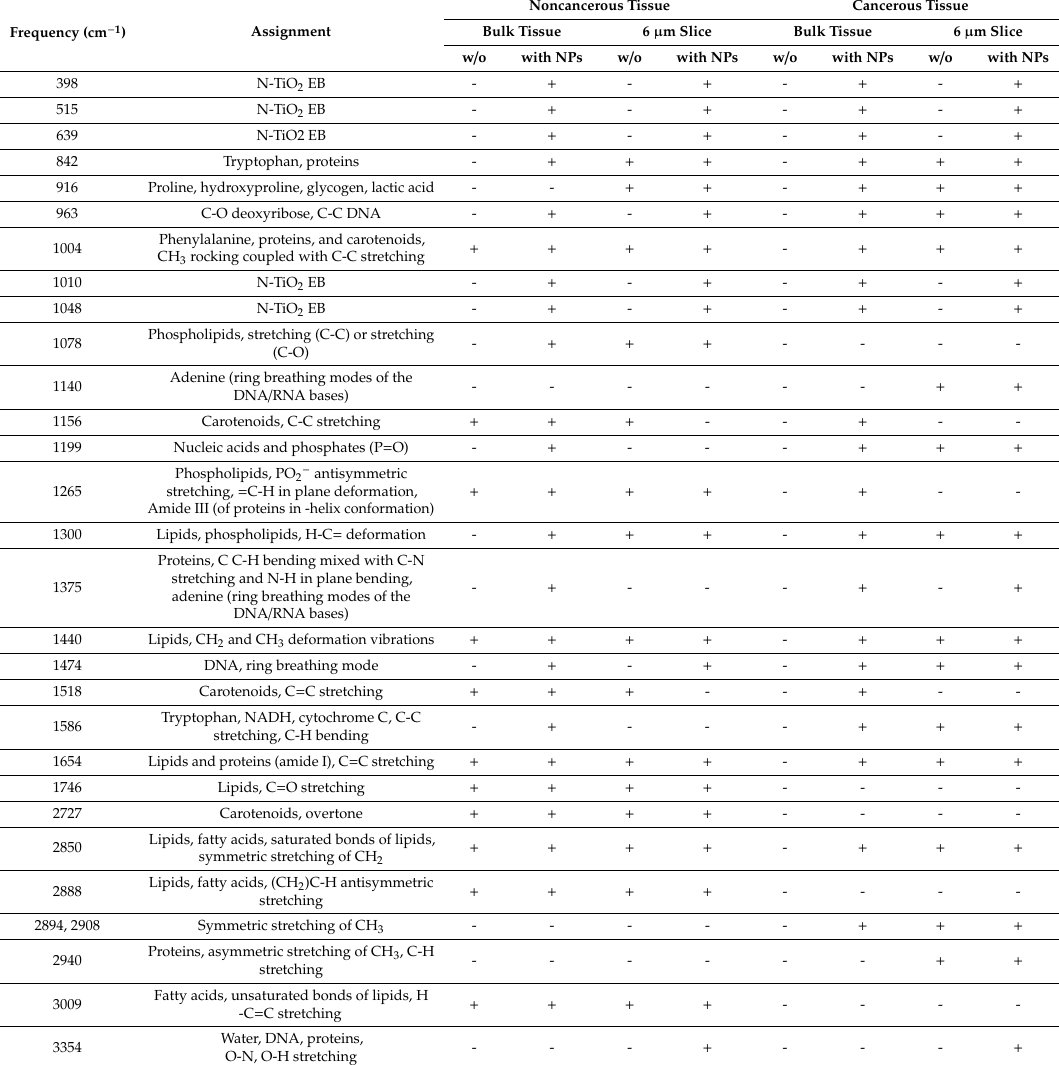
Table 1. Peak allocations for carotenoids, lipids, carbohydrates, DNA, and proteins [12,24–26] together with an indication of the observed changes with and without the addition of N-doped TiO 2 electron beam-irradiated nanoparticles